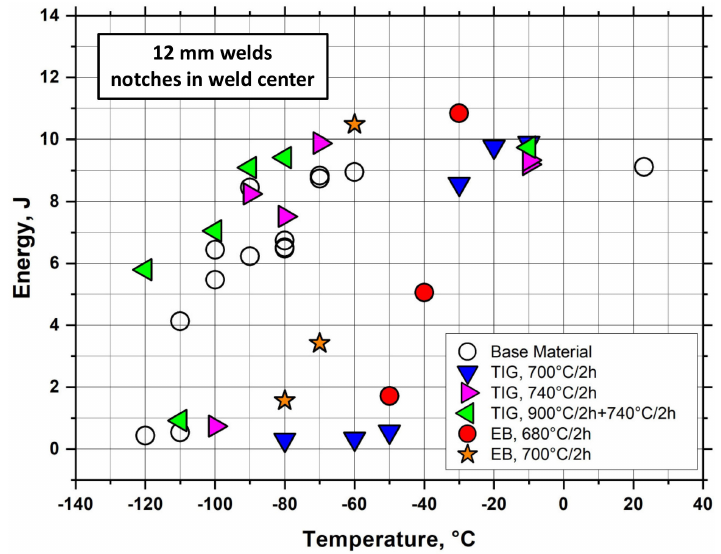
Figure 15. Charpy test results of 12 mm TIG and EB welds. The notches of the Charpy specimens were fabricated in the top of the weld center. The effect of PWHTS (indicated in the legend) is shown. For comparison, results of the base material (EUROFER97/2) after standard heat treatment are also plotted.